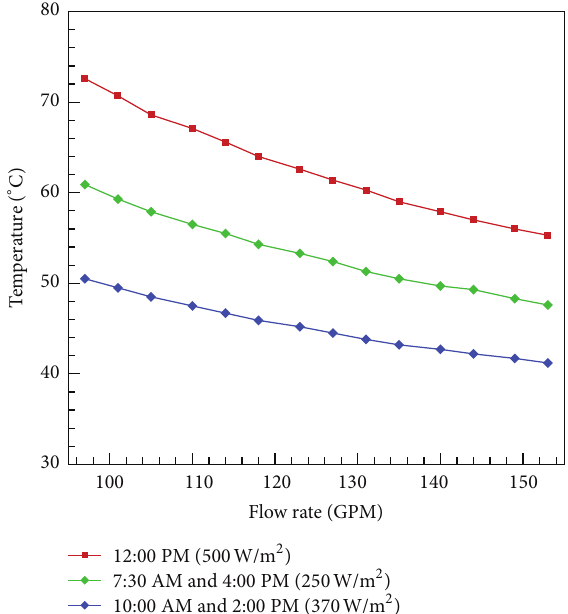
Figure 3: Cost comparison for EPDM and copper piping.